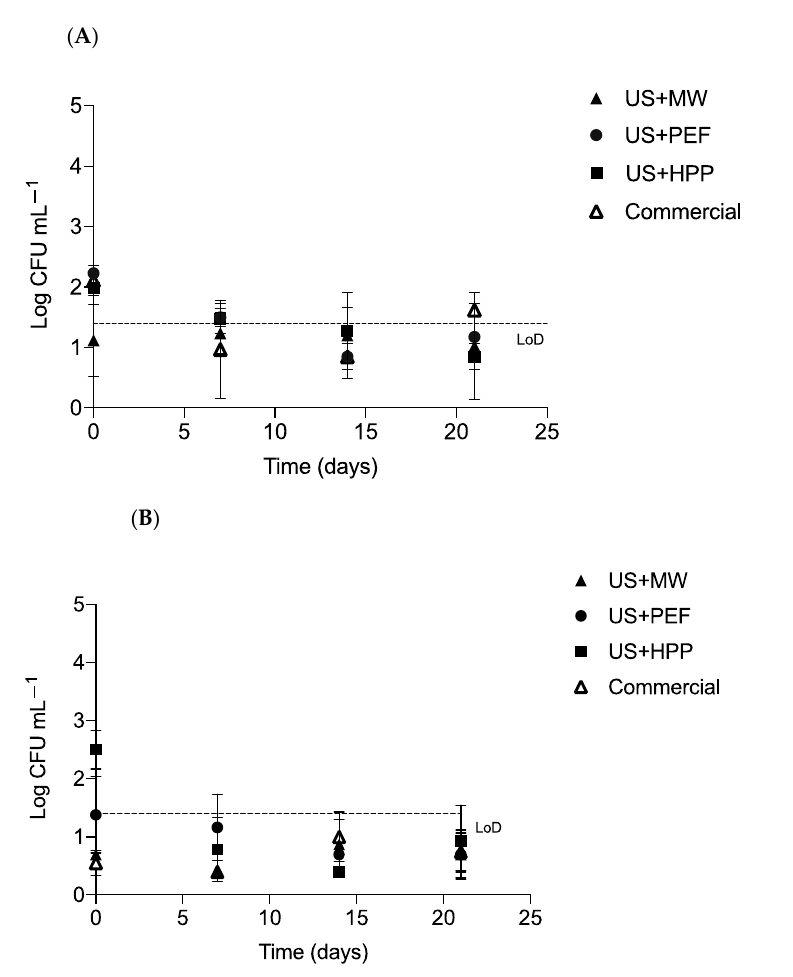
Figure 6. Microbial growth in milk during storage at 4 ◦ C up to 28 days: ( A ) incubation at 37 ◦ C; ( B ) incubation at 15 ◦ C. Bacterial counts were measured on PCA plates ( n = 6). The standard error of means is shown as whiskers. The detection level is indicated by the do tt ed line.